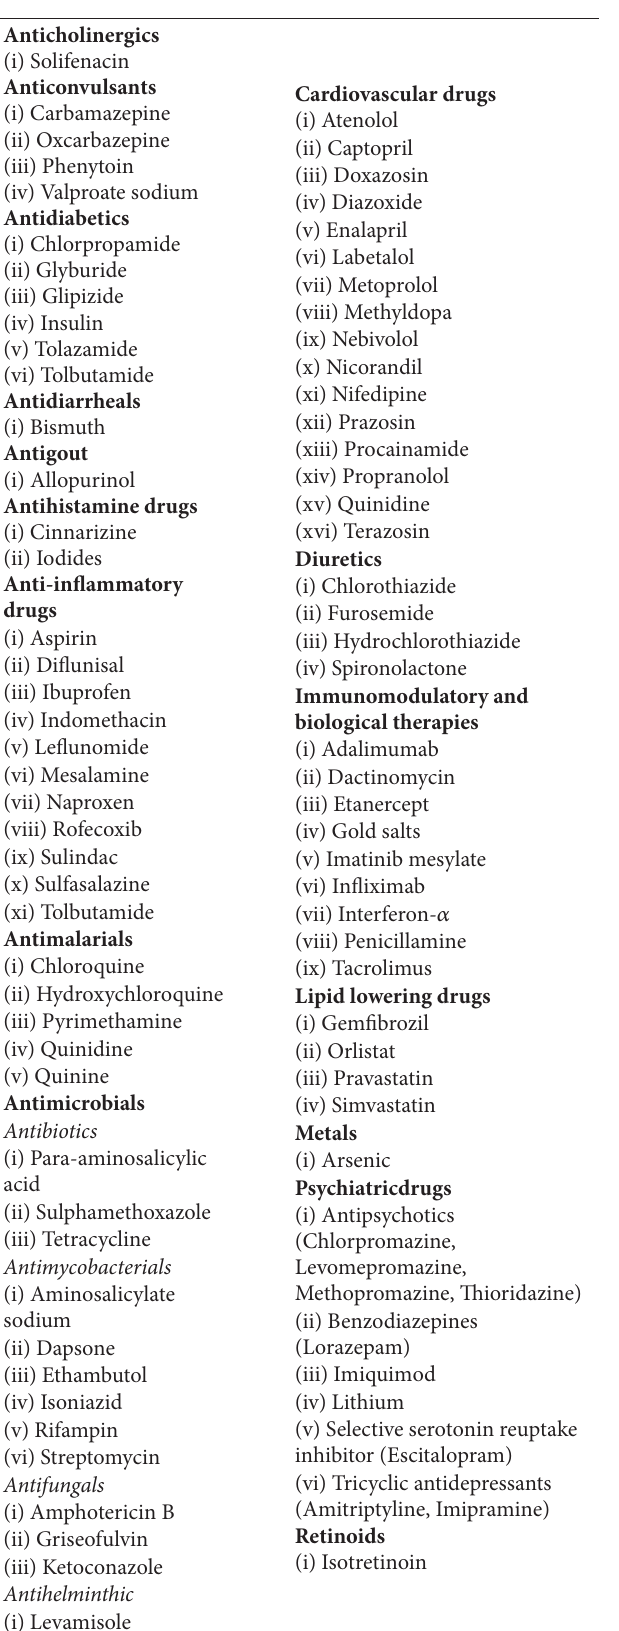
Table 3: Drugs responsible for lichenoid reaction.